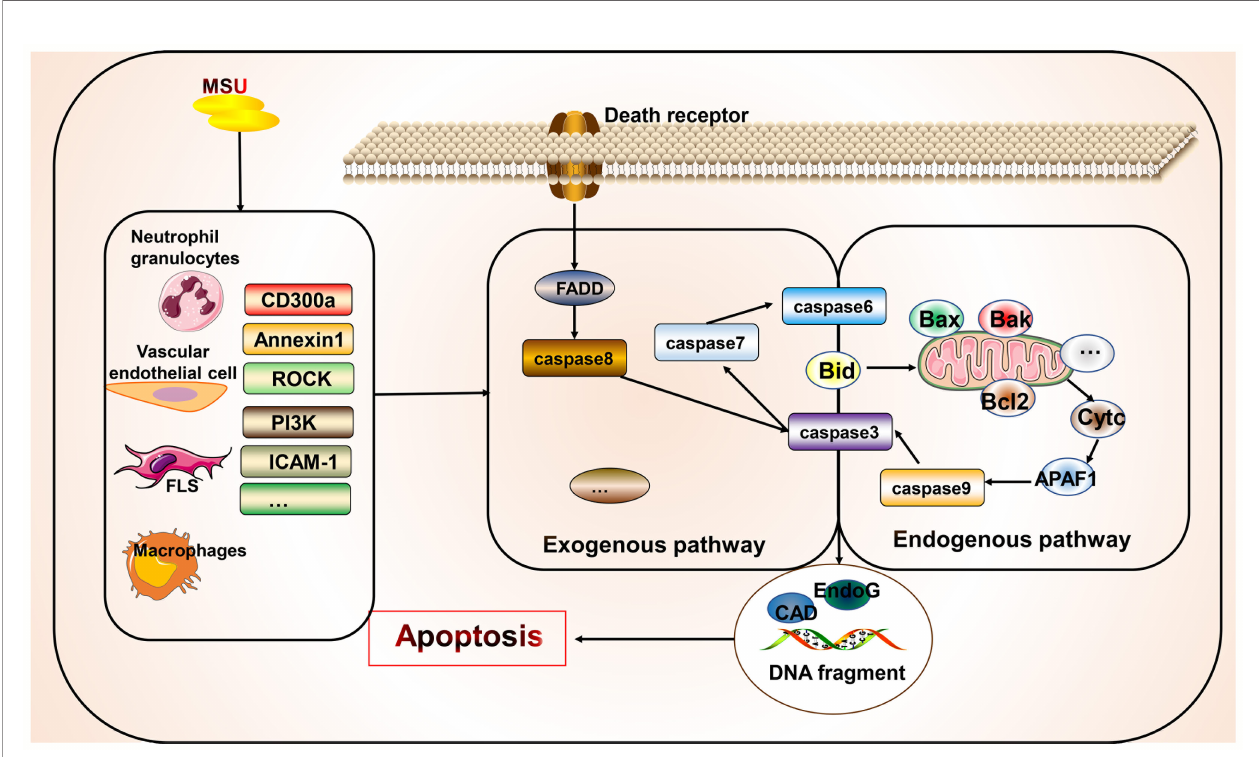
FIGURE 4 | Association of apoptosis with gout. Apoptosis occurs primarily via endogenous and exogenous pathways. Apoptosis exists in various cells in gout but has not been widely examined. However, the managing gout involves inhibiting the apoptosis of bene fi cial cells and promoting the apoptosis of harmful cells. Some apoptosis-related molecular targets such as CD300a have been identi fi ed and require further